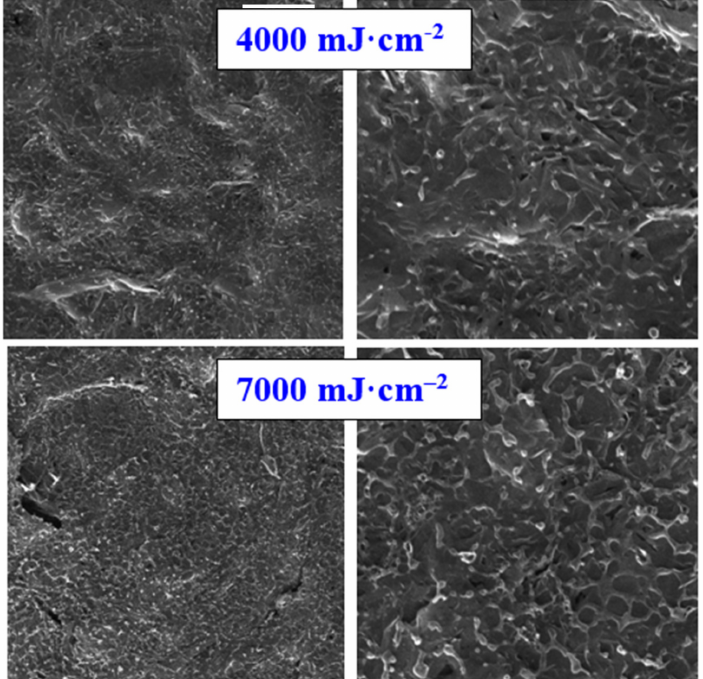
Figure 2. Scanning electron microscopy images of carbon sheet exposed with high-energy excimer laser and laser fluencies for 4000 and 7000 mJ · cm − 2 . The scanning areas were 10 × 10 µ m 2 ( right col- umn) and 30 × 30 µ m 2 ( left column). White lines represent six microns ( left ) and two microns ( right